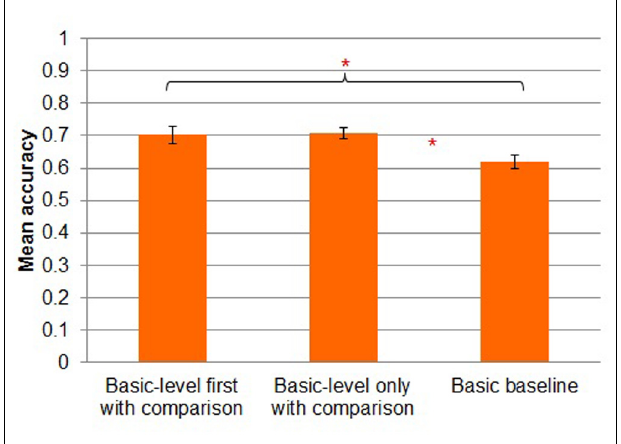
FIGURE 6 | Mean accuracy by study condition in Experiment 2. Error bars represent SEs. * p <